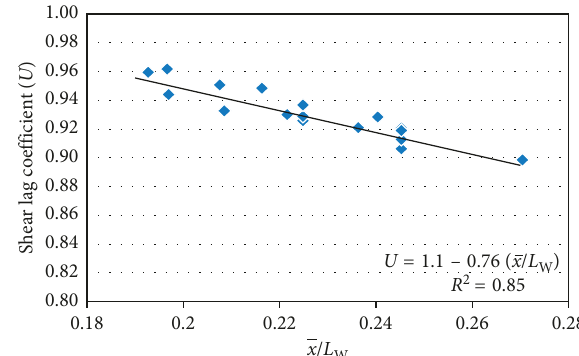
Figure 16: Proposed equation for the double angle compared to FE